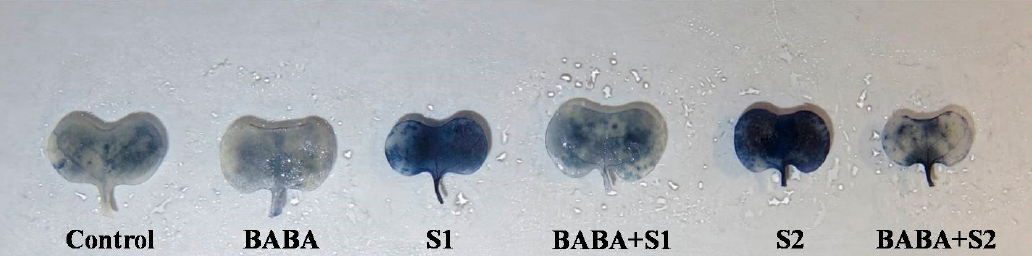
Figure 1. Effect of BABA on the superoxide (O 2•– ) accumulation of rapeseed ( Brassica napus L.) Figure 1. E ff ect of BABA on the superoxide (O 2 • – ) accumulation of rapeseed ( Brassica napus L.) seedlings exposed to different concentrations of salt stress. Here, BABA, S1 and S2 indicate 150 μ M seedlings exposed to di ff erent concentrations of salt stress. Here, BABA, S1 and S2 indicate 150 µ M β -aminobutyric acid, 100 mM NaCl, and 150 mM NaCl, respectively. β -aminobutyric acid, 100 mM NaCl, and 150 mM NaCl,